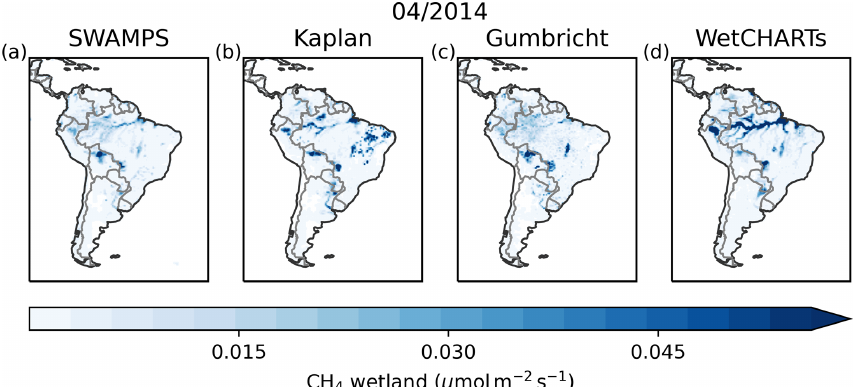
Figure A2. CH 4 emissions for each of the four a priori wetland emissions used in the wetland extent sensitivity study. Panels (a) – (c) SWAMPS, Kaplan and Gumbricht fractional maps are combined with the JULES emissions output. Details of these inversion setups are described in Table 2. This is shown for April 2014 which is a wet season month with high emissions in the Amazon basin and the Pantanal